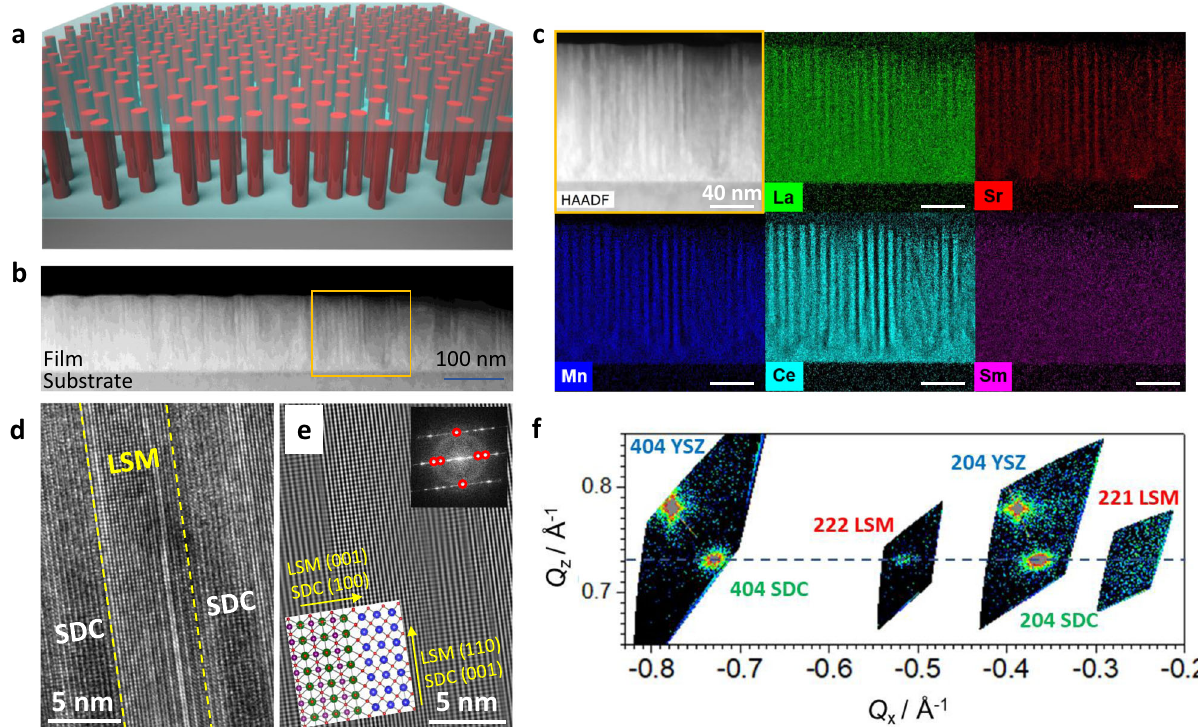
Fig. 1 Structural investigation of LSM-SDC. a Sketch of the LSM-SDC VAN structure. b Low-magni fi cation image of the fi lm, highlighting the long-range order of the pillar structure. The thickness decrease on the right side should be ascribed to TEM lamella preparation. c HAADF image and EDS colour maps for a representative columnar region of the fi lm. d HR-TEM of the alternating SDC and LSM columnar structure. e IFFT of ( d ). The atomic ordering and the epitaxial relationship between the LSM (out-of-plane [110], zone axis [1-10]) and the SDC (out-of-plane [001], zone axis [100]) regions is clearly visible, as schematically sketched by the bottom inset. In the top inset, the original FFT and the fi ltered re fl ections (highlighted by the red circles) are shown. f RSM of the out-of-plane matching (001)-oriented SDC domains (404 and 204 SDC re fl ections) and (110)-orientedLSM domains (222 and 221 re fl ections). The 404 and 202 YSZ substrate re fl ections are also visible. The dotted horizontal line passes through the maxima of the LSM and SDC re fl ections, highlighting perfect out-of- plane lattice match between the two phases. Please note that the structural investigation was carried out after thermal ageing (700°C,